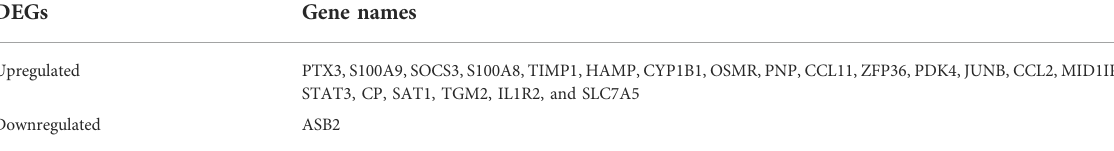
TABLE 3 Signi fi cantly enriched GO terms and KEGG pathways of